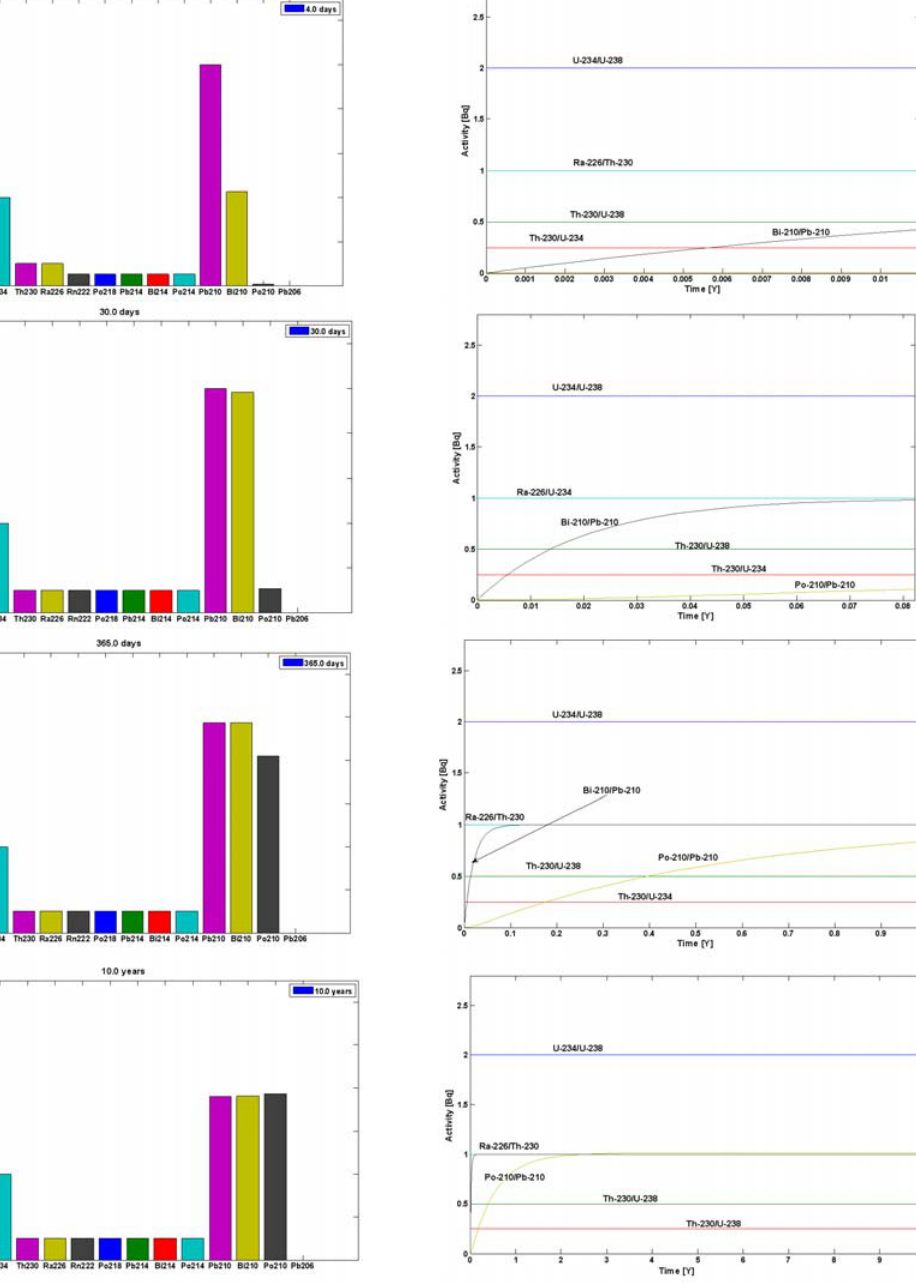
Fig. 7 Demonstration of the 238 U decay chain evolution from 4 days to 100 years. Initial conditions were selected for five nuclides: 238 U 1 Bq, 234 U 2 Bq, 230 Th 0.5 Bq, 226 Ra 0.5 Bq and 210 Pb 5 Bq. The high activity of 210 Pb compared to other nuclides demonstrates the presence of fallout 210 Pb. Note the presence of 210 Bi (T 1